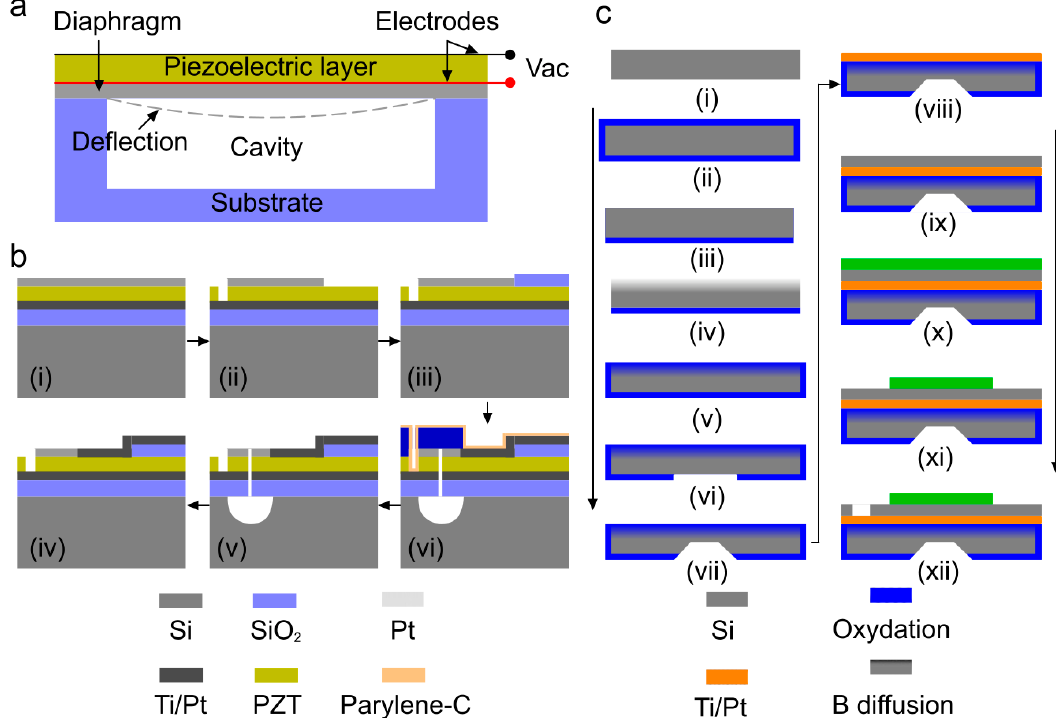
Figure 3. Piezoelectric micromachined ultrasound transducers (PMUT) technology. (a) Schematic